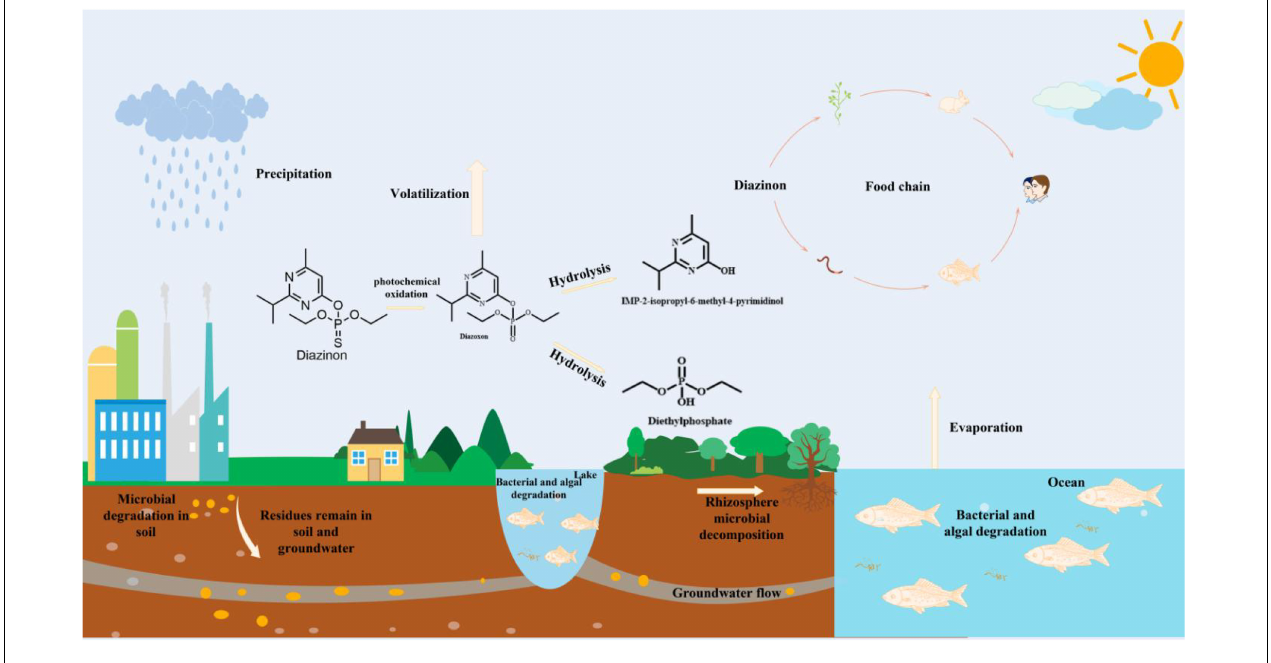
FIGURE 1 | The fate and occurrence of diazinon in the environment.